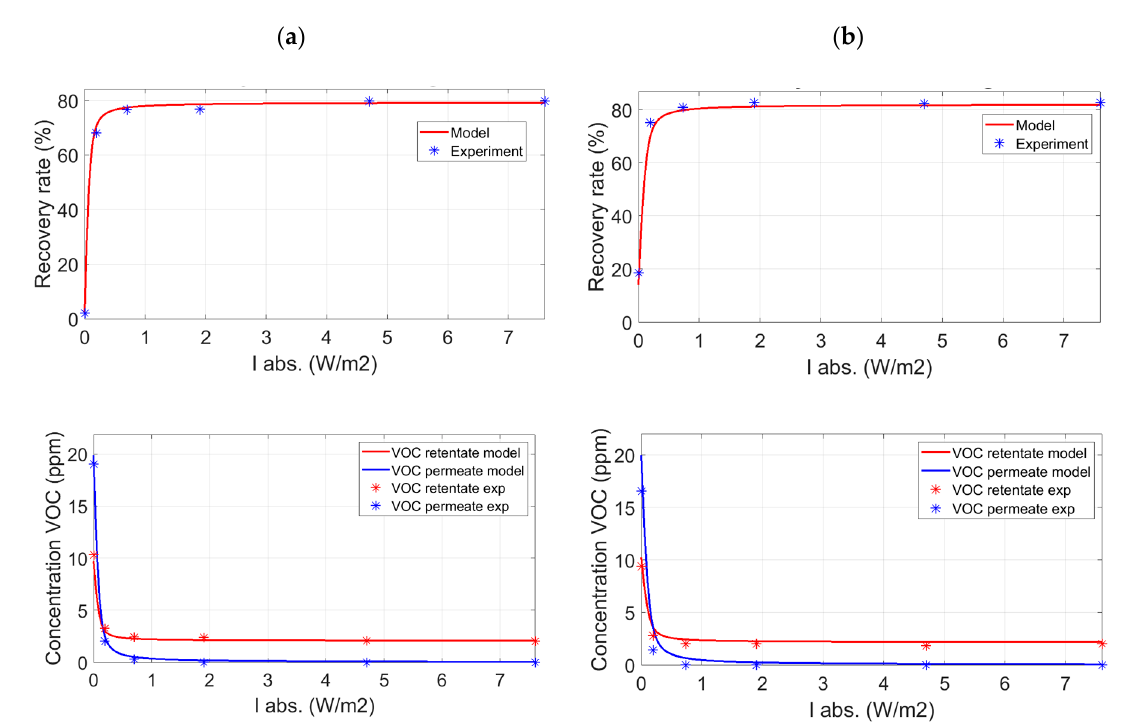
Figure 4. Toluene recovery ratio and toluene retentate/permeate concentrations vs. I abs for the PDMS membrane ( a ) and the PolyActive membrane ( b )—catalyst m 2 − 𝜓 (cid:3404) 0.98/2 —without sweep gas.